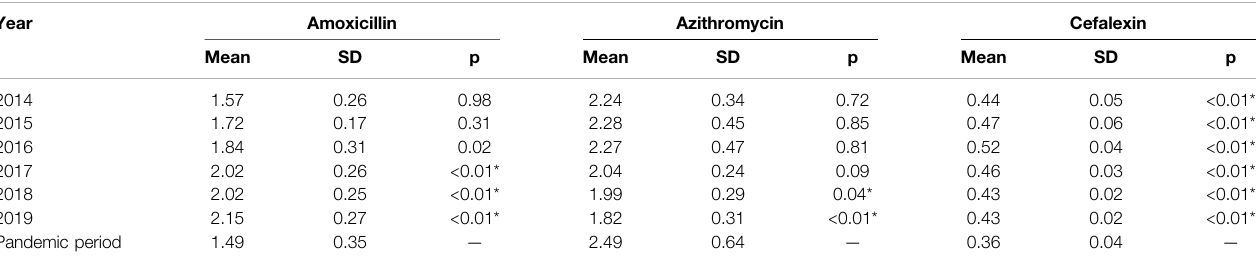
TABLE 2 | De fi ned Daily Dose per 1,000 inhabitants per day (Mean), Standard Deviation (SD) and p value of amoxicillin, azithromycin, and cefalexin before and during Pandemic period in Brazil, per